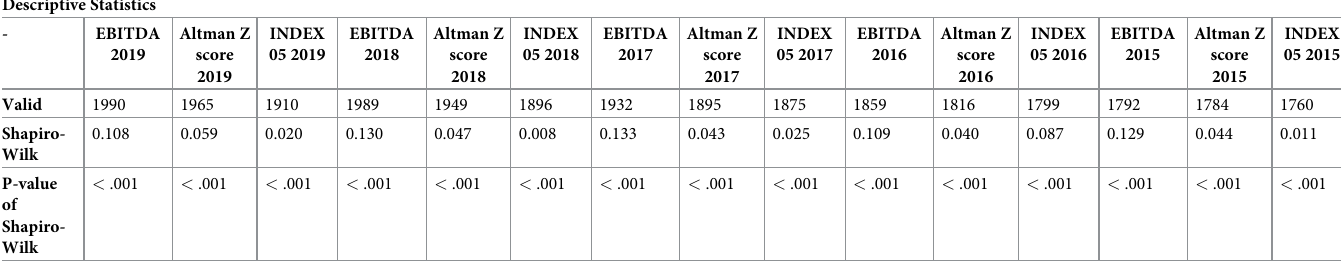
Table 4. Descriptive statistics of the Shapiro-Wilk test.